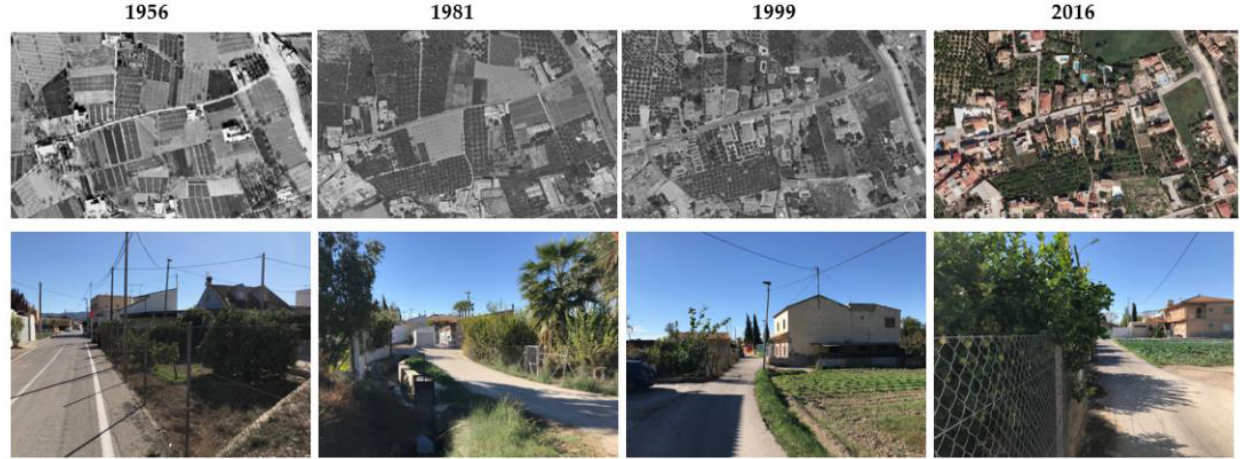
Figure 9. Example of evolution over time of a traditional orchard area in the metropolitan area of Murcia (above). Images of the current landscape configuration of the old peri-urban areas of Huerta: the construction of numerous paved roads as a consequence of an increasingly fragmented plot structure focused on residential urban development has ended up completely misconfiguring the natural hydrographic network (below).